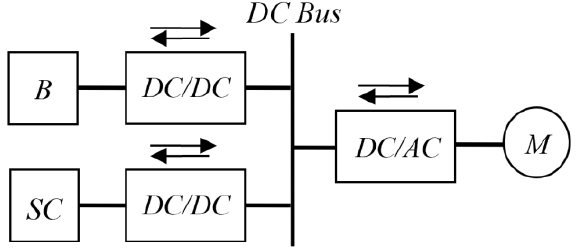
Figure 6. Combined vehicle system with a controlled battery as the main power source.